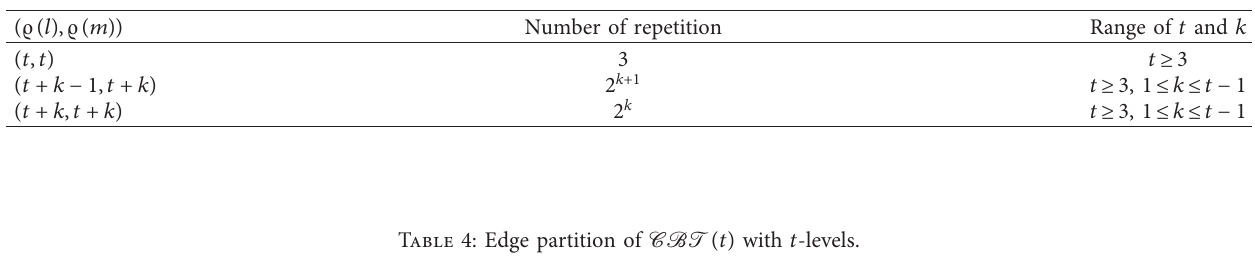
Table 3: Edge partition of CBT ( t ) for t -levels.